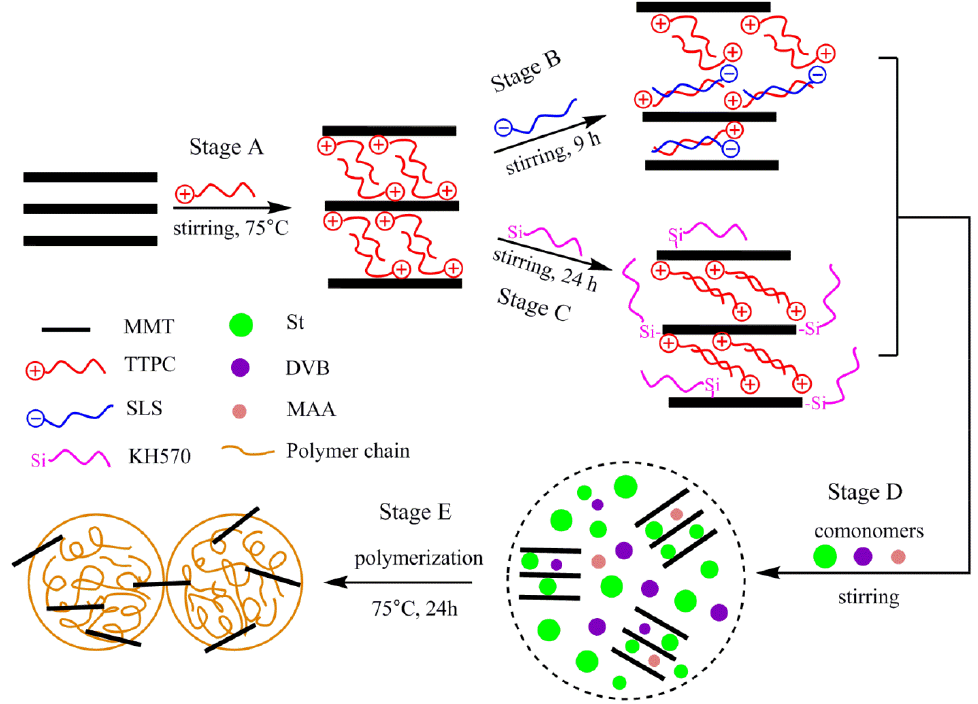
Figure 1. Schematic representation of the processes of preparing the organo-montmorillonite (OMMT) and the polystyrene (PS)/OMMT nanocomposites. 149